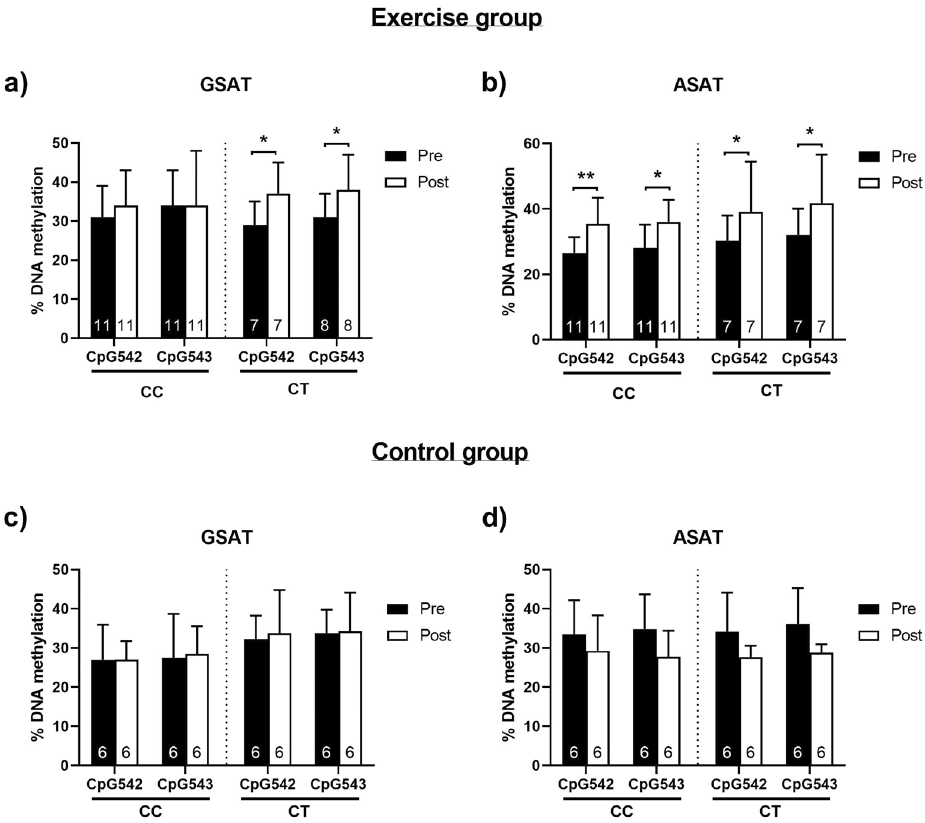
Figure 3. Genotype effect of rs1360780 on FKBP5 CpG542 and CpG543 methylation in gluteal adipose tissue (GSAT) and abdominal adipose tissue (ASAT) in exercise participants (CC n = 11, CT n = 7) ( a, b ) and GSAT and ASAT in control participants (CC n = 6, CT n = 6) ( c, d ), pre- and post-intervention. Data represented as mean ± SD. * p < 0.05, ** p < 0.01.